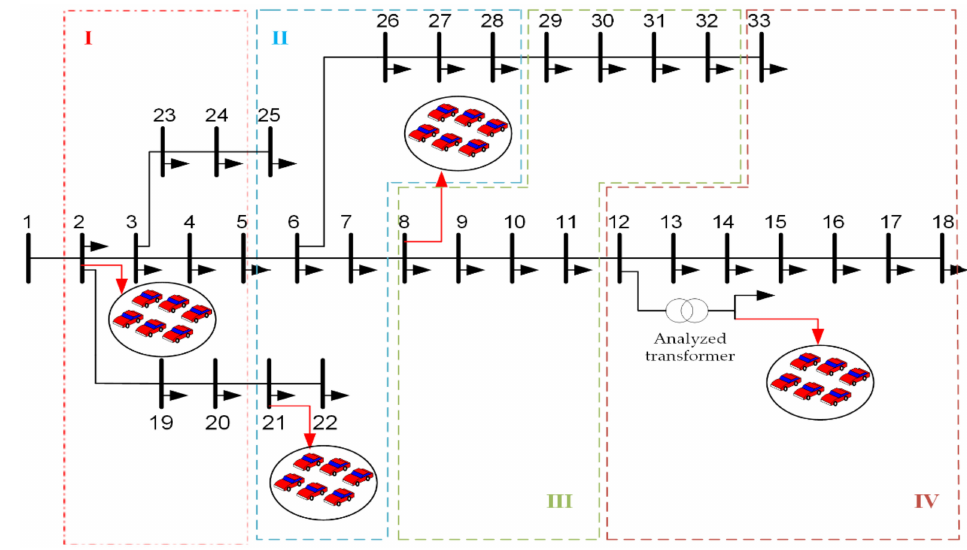
Figure 9. Single-line diagram of 33-bus test system.